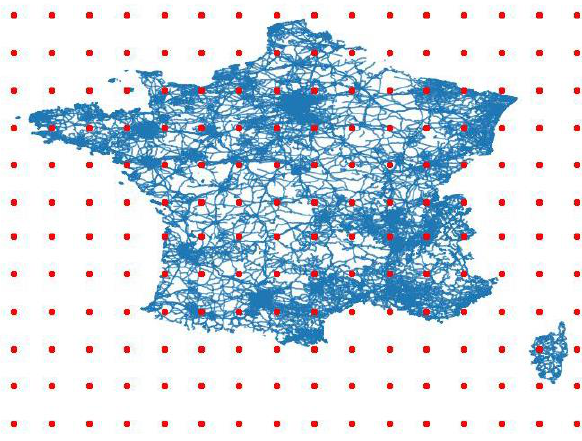
Figure 4. Locations of temperature forecasting with a resolution of 1° over France.